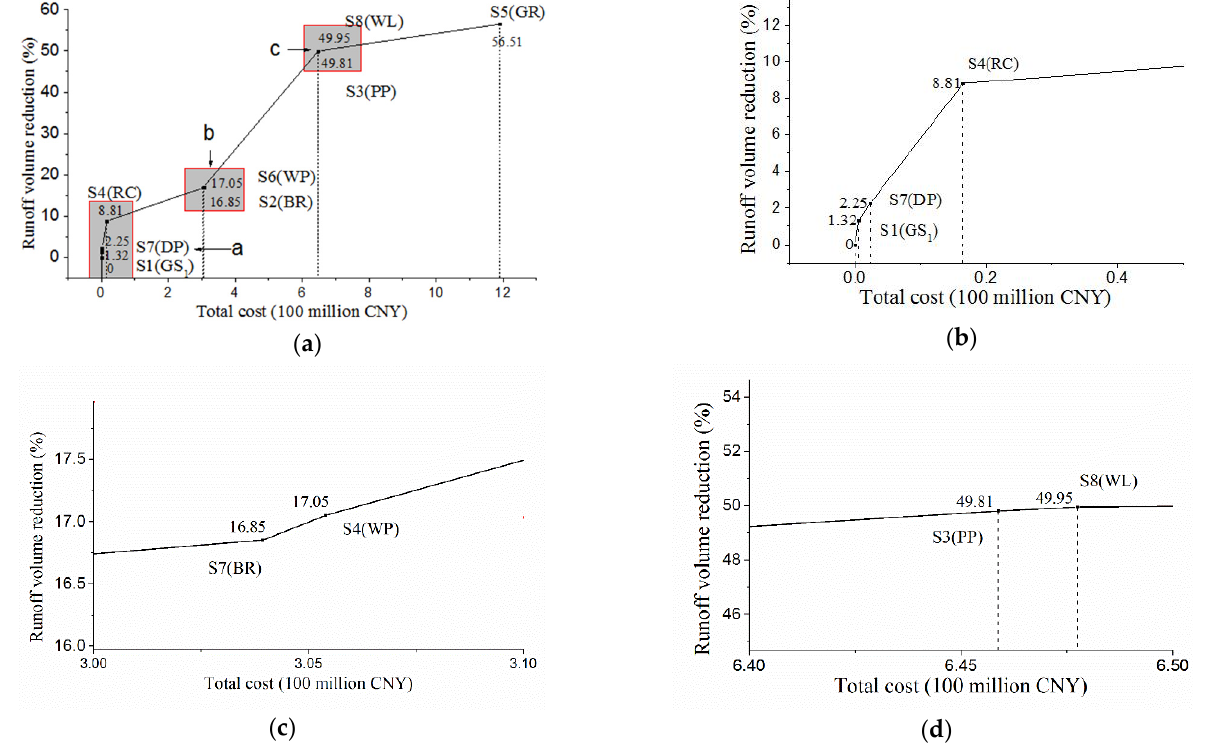
Figure 4. Relationship between total cost and runoff volume reduction with GI practices implemented independently. ( b) , ( c) and ( d) were a partial magnification of ( a ).